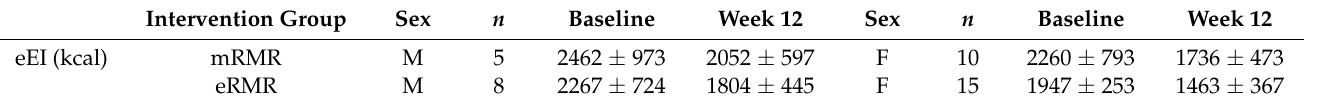
Table 6. Estimated energy intake at baseline and week 12 for male and female participants.